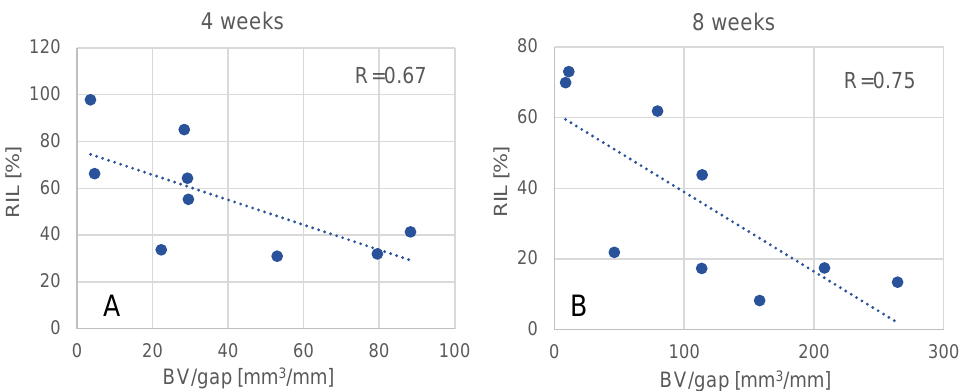
Figure 5. Correlation between relative implant load (RIL) and normalized bone volume (BV/gap) at 4 weeks ( A ) and 8 weeks ( B ).